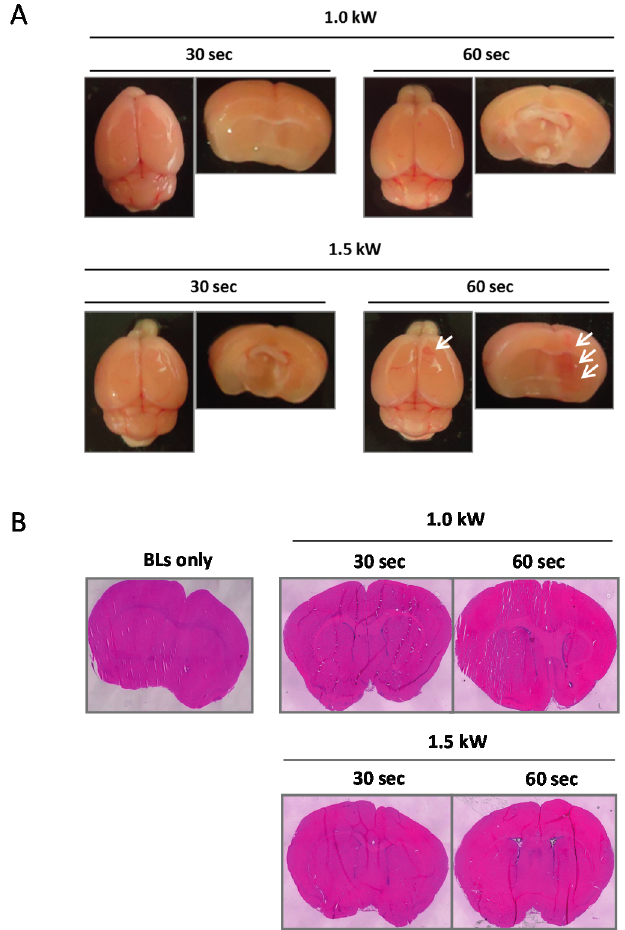
Figure 5. Histological analysis of brain after treatment with HIFU exposure. BLs were intravenously injected into mice, and then the right hemispheres were exposed to 3.5 MHz pulsed HIFU conditions (intensity: 1.0 or 1.5 kW/cm 2 , exposure time: 30 or 60 s). Twenty-four hours after the treatment, each brain was dissected. ( A ) The appearance of the whole brain and its coronal section. The white arrow indicates the region of erythrocyte extravasations in the exposure site. ( B ) H&E staining. Each brain section was sliced at 10 µm ( n = 3). Each coronal section underwent H&E staining. Each specimen was observed using a light microscope. BL: Bubble